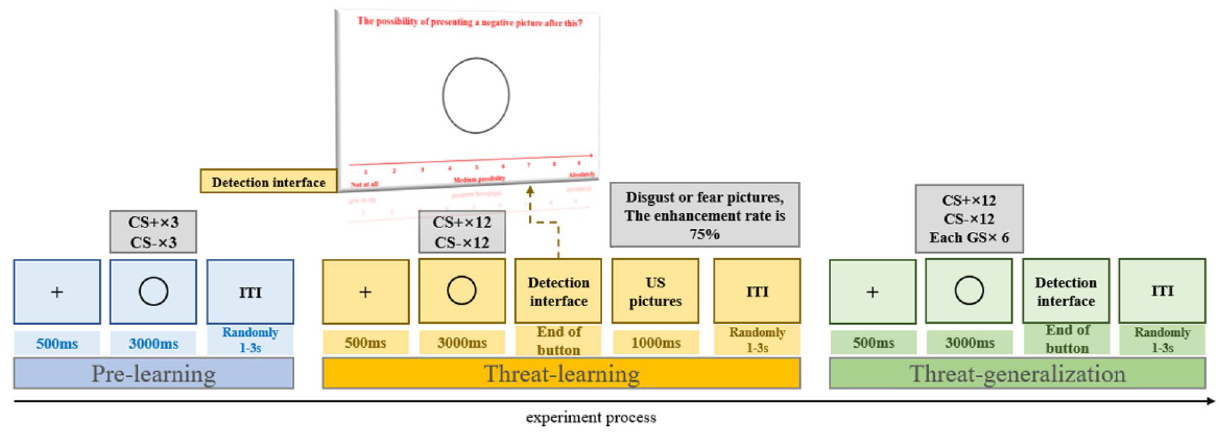
Figure 2. The experimental